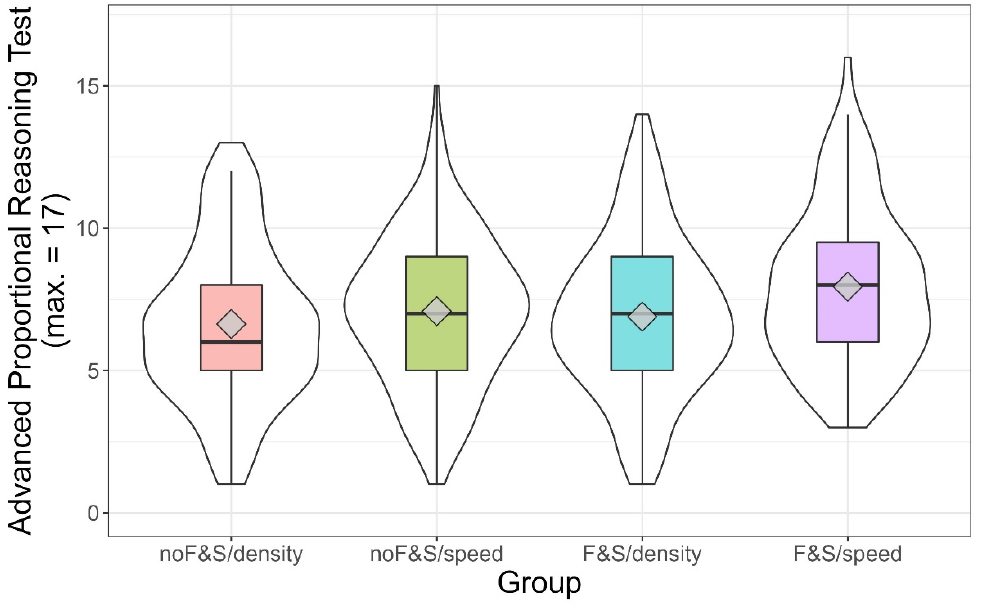
Figure 4. Score in proportional reasoning test by group in Study 2. Violin plots (white) and boxplots (colored). The diamond depicts the mean value per group.